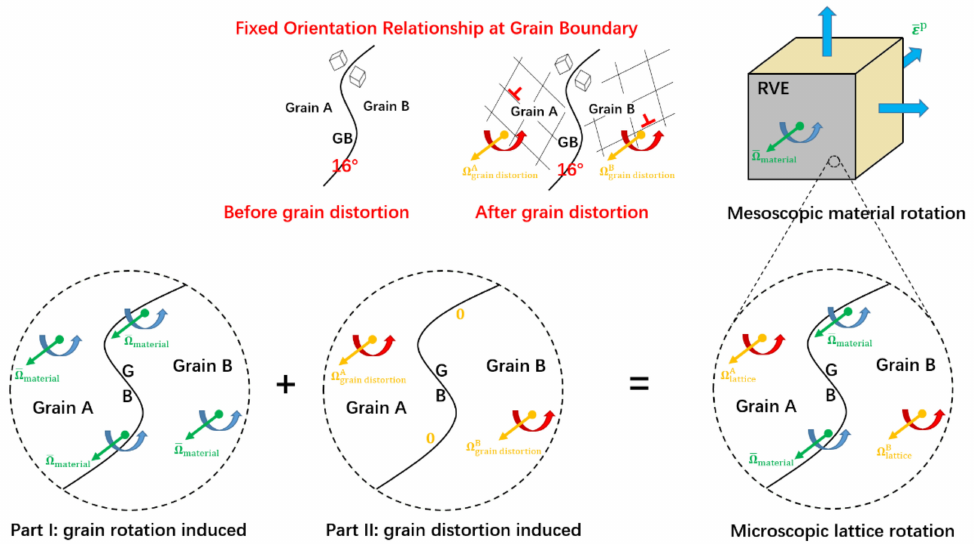
Figure 9. The explanation for the fixed orientation relationship between two sides of